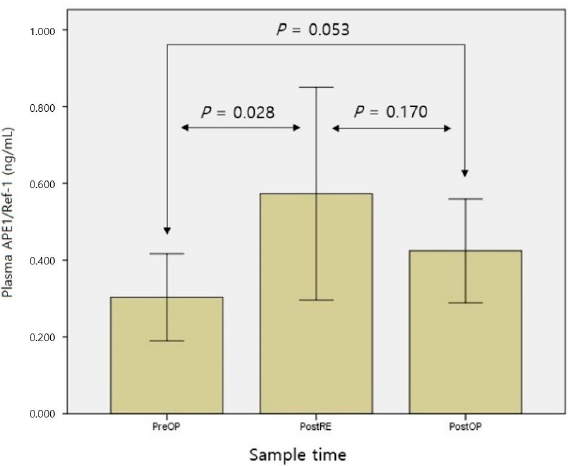
Figure 4. Comparison of plasma APE1/Ref-1 level according to measurement time. PreOP, preoperative sample; PostRE, postresection sample; PostOP, postoperative sample.